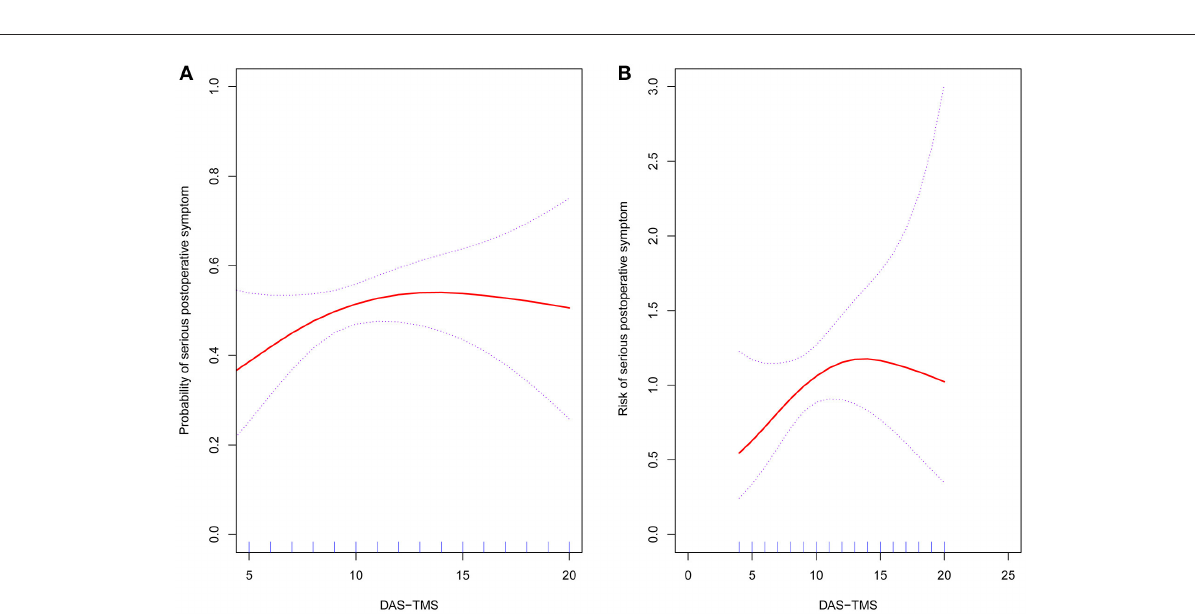
FIGURE4 The relationship between DAS-TMS and the risk of severity of postoperative symptoms following LM3 surgery. A non–linear relationship between the DAS-TMS and risk of severity of postoperative symptoms was observed after adjusting for impaction status (Pell-Gregory’s classification, Pell-Gregory’s occlusion, Winter classification), operation time, gender, and age. (A) Probability of serious postoperative symptom; (B) Risk of serious postoperative symptom.